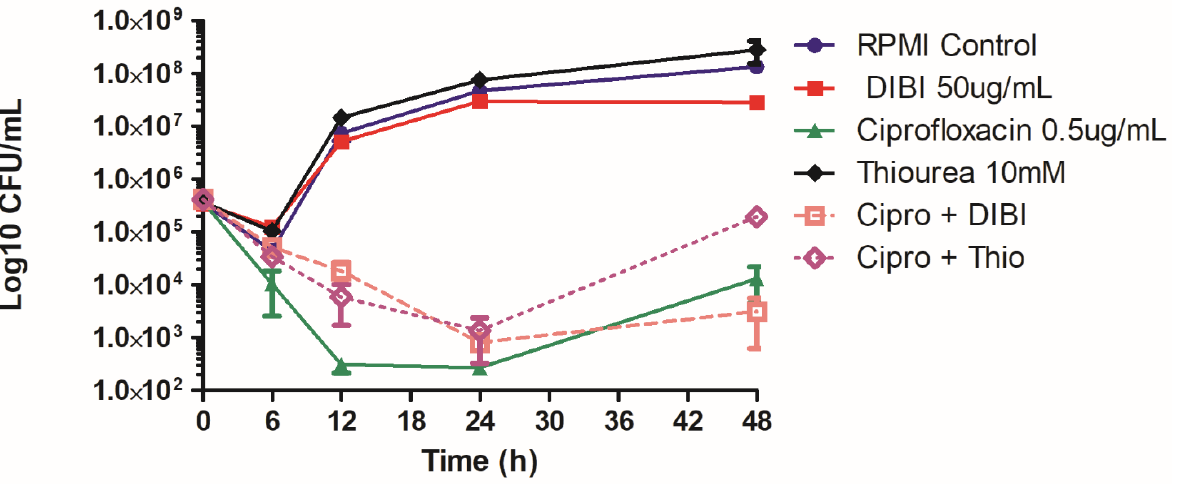
Figure 1. Effects of ciprofloxacin, DIBI and thiourea on Staphylococcus aureus killing and recovery growth. ATCC 25923 was grown in MHB and a standardized inoculum was added to 10 mL flask cultures of untreated RPMI control (●), RPMI with added 50 µg/mL DIBI ( ▪ ), 0.5 µg/mL CIP ( ▲ ), 10 mM thiourea ( ♦ ), 50 µg/mL DIBI combined with 0.5 µg/mL CIP (□) and 10 mM thiourea combined with 0.5 µg/mL CIP ( ◊ ). Samples obtained during exposure were plated onto BA and CFU/mL was determined. The data represent means ± SEM for three independent experiments.